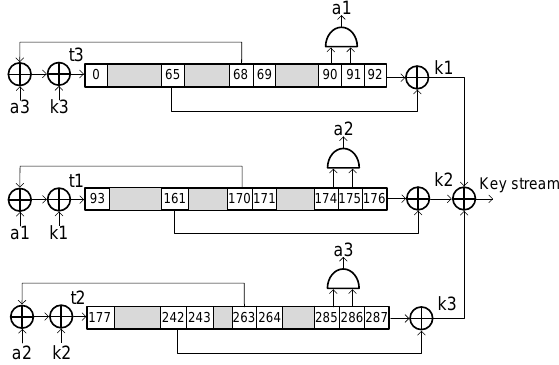
Figure 2. Schematic representation of the Trivium stream cipher internal